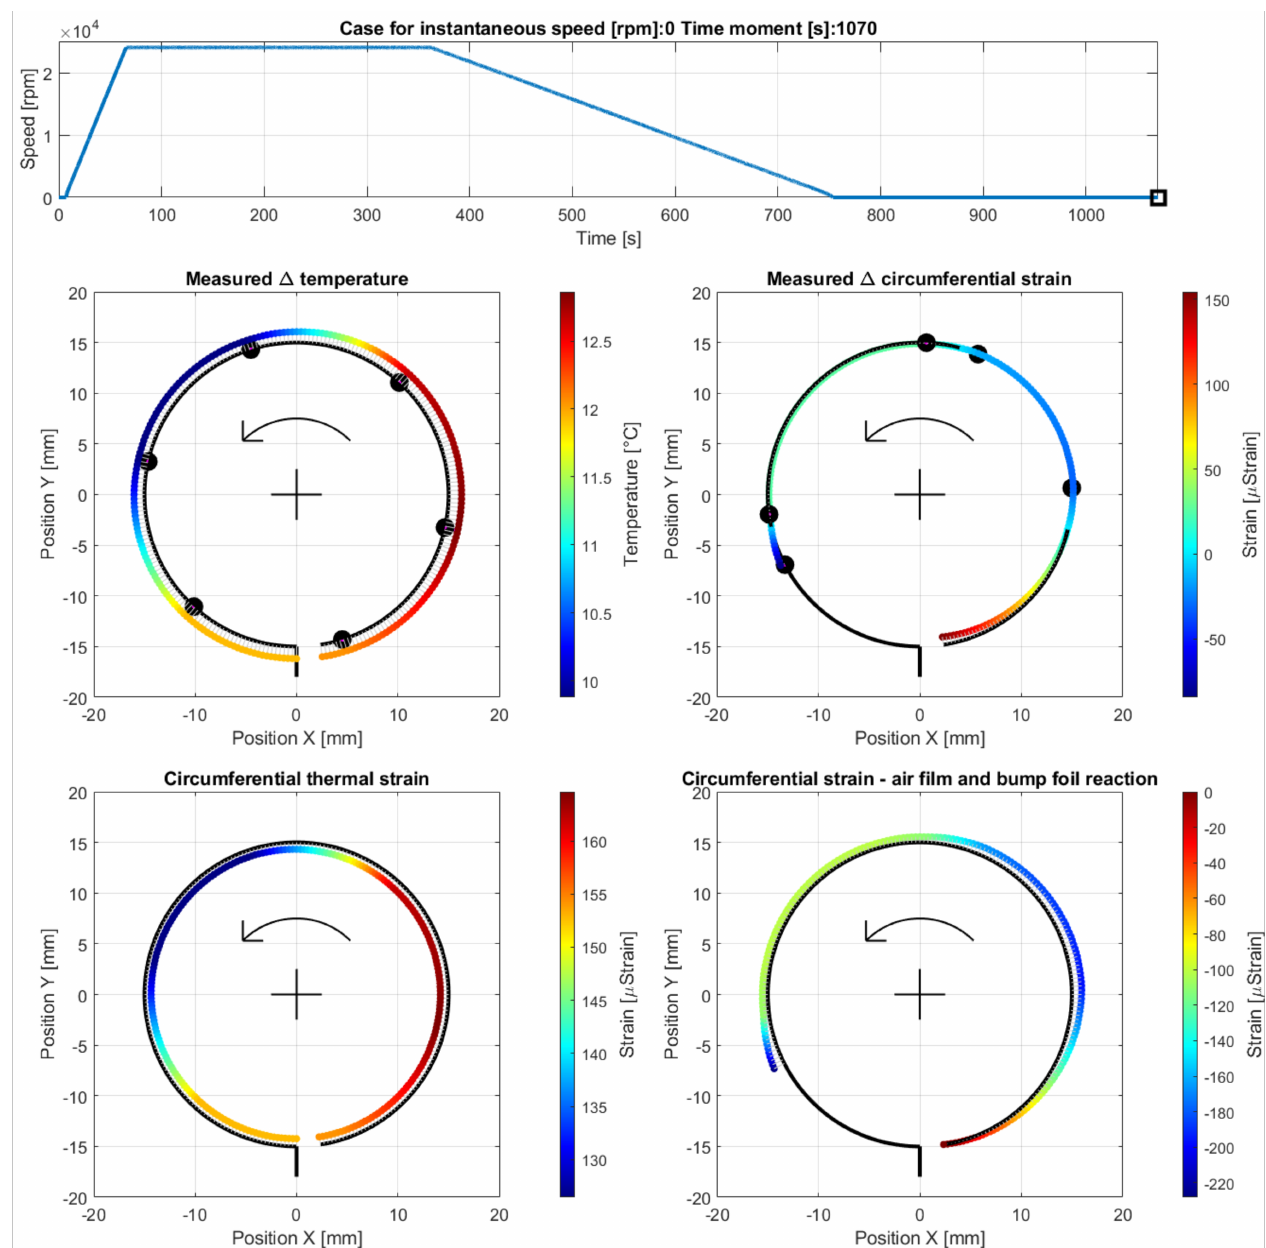
Figure 18. Cross-sectional views for the circumferential distribution of the temperature and strain identified in the top foil at the stopped shaft at the end of the measurements. The curves used to visualize the strains are rescaled by the factor 0.5 compared to Cases A to